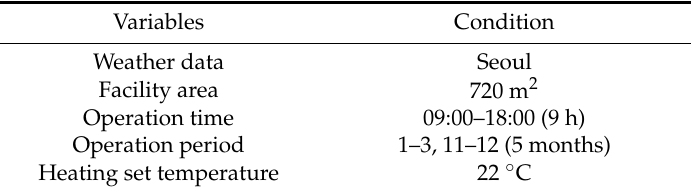
Table 4. Simulation conditions.